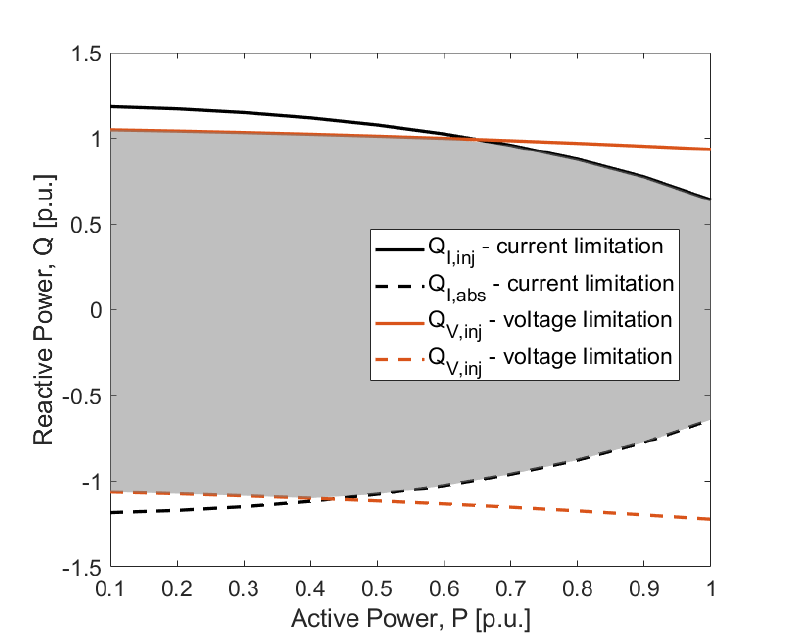
Figure 3. Illustration of voltage-limited and current-limited reactive power